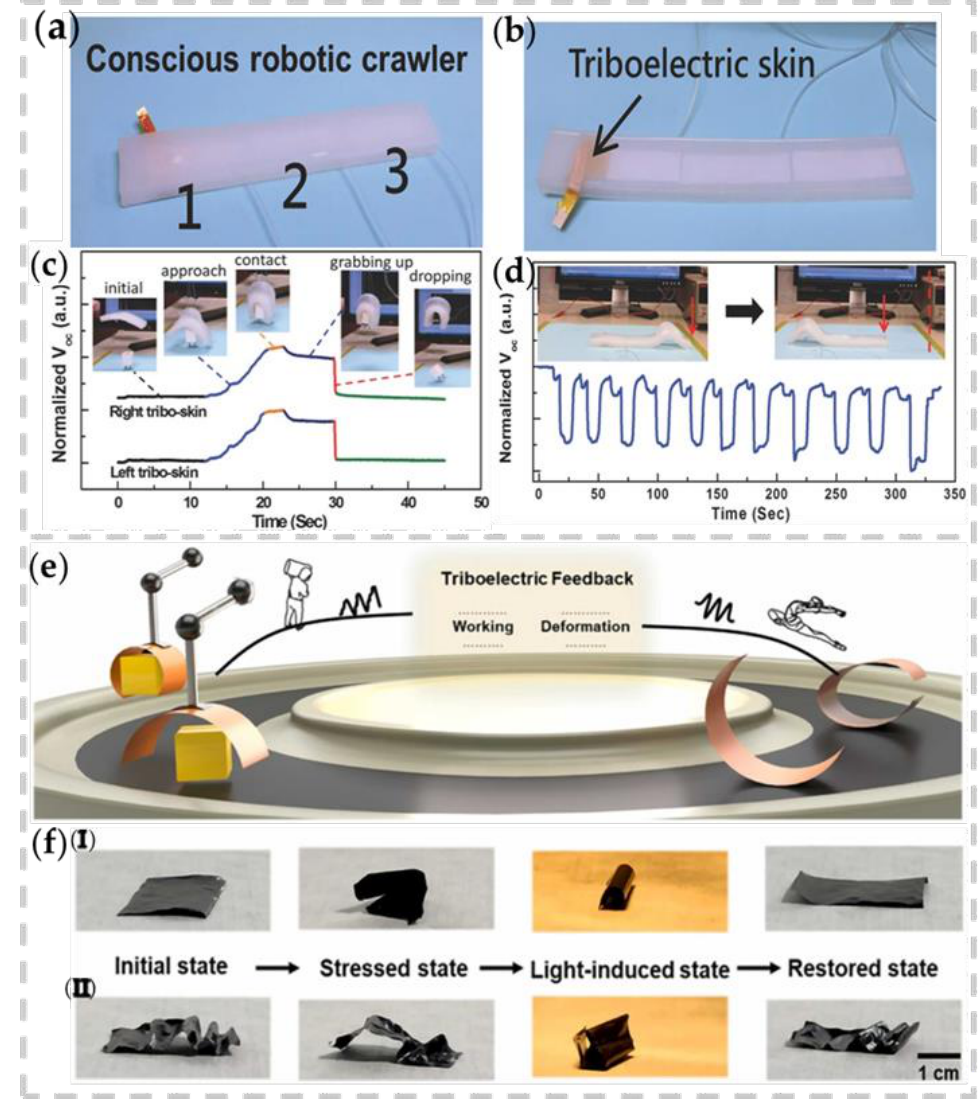
Figure 13. ( a ) Image of conscious robotic crawler(1, 2, and 3 are three signal ports). ( b ) The appearance of the abdomen of a conscious robotic crawler and tribo-skin. ( c ) Tribo-skins enable soft robotic gripping to finger to perceive working states actively. Real-time outputs of right and left tribe-skins when conscious gripper grabbed and dropped an object. ( d ) Real-time results of conscious crawler during crawling ≈15 cm distance [118]. Copyright 2018, WILEY-VCH VERLAG GMBH. ( e ) Schematic of the contact feedback of the PCPA. ( f ) Photographs of PCPA demonstrating the shape-memory diversity [119]. Copyright 2022,